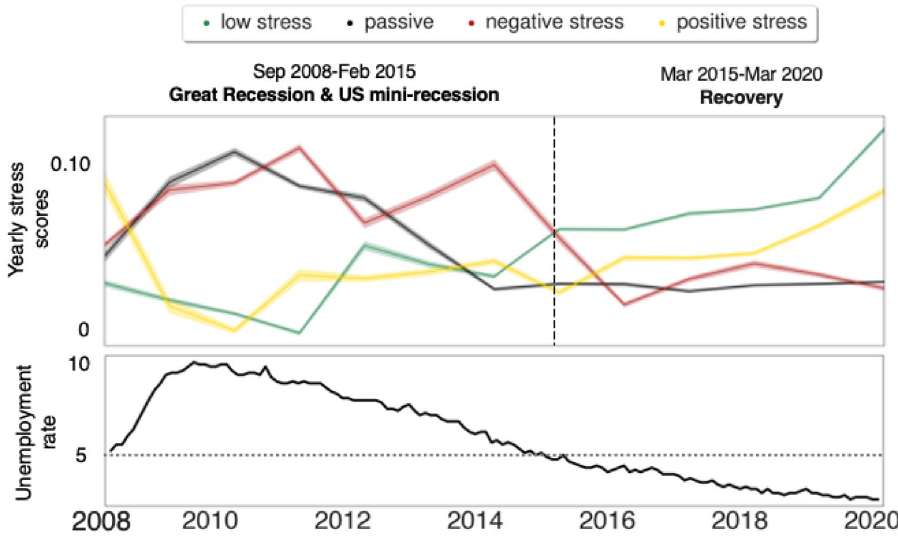
Figure 2. The evolution of: (top) the four types of stress; and (bottom) the unemployment rate in the U.S., with the horizontal dashed line reflecting pre-recession rate. The stress score per year is calculated using Eq. (2), and its standard deviations are shown with shaded lines.